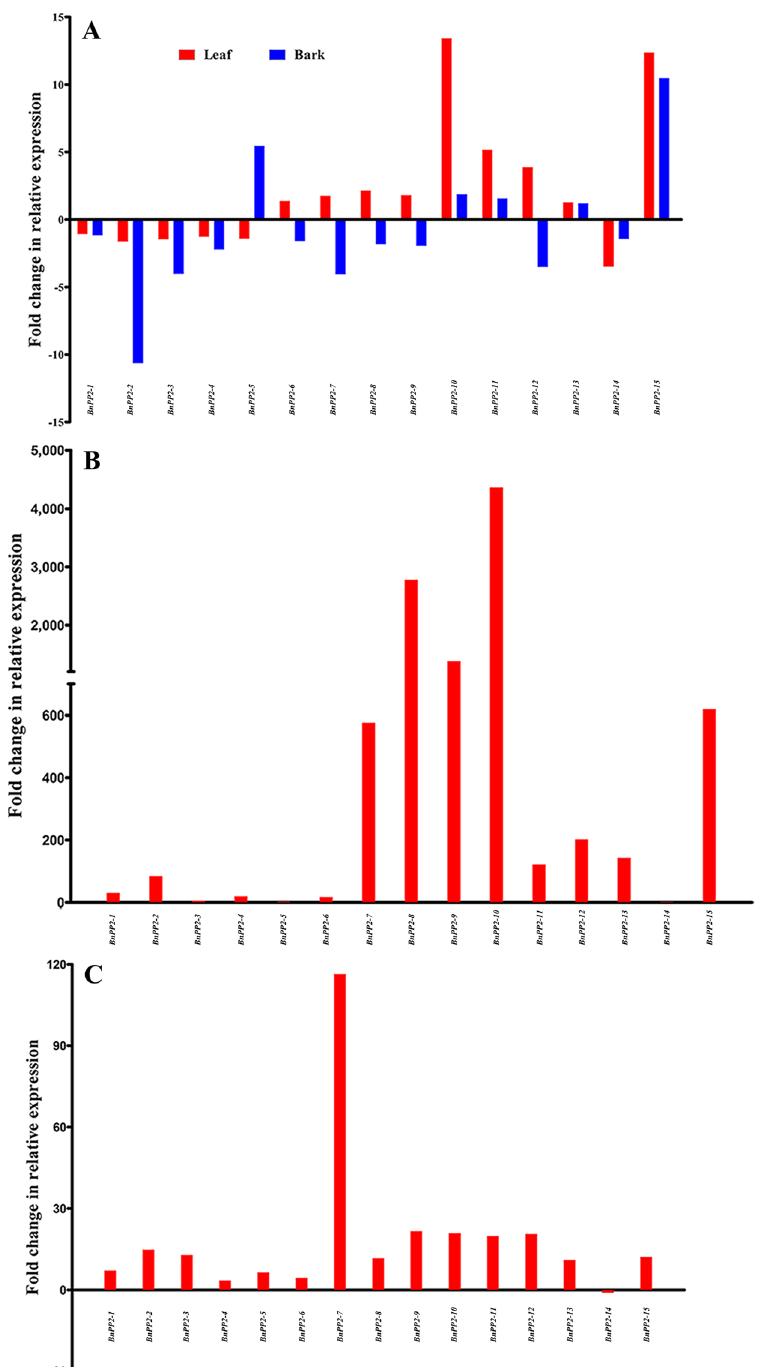
Figure 5. The fold change in relative expression of BnPP2 genes in response to MW, IF and FI. Expression data were presented as fold change by comparing with the control. The blue color block represents data for leaf, while the red color block indicates bark. ( A ) MW (mechanical wounding); ( B ) Insect-feeding; ( C ) Fungal infection. The fold change was calculated by REL (Treatment)/REL (control) (up-regulated) or REL (control)/REL (Treatment)